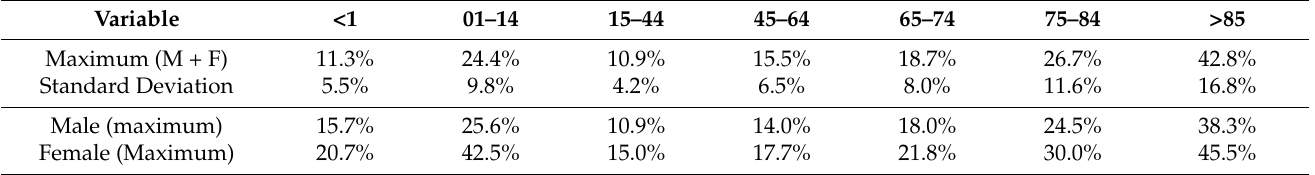
Table 2. Maximum value of EWM in England and Wales (2010–2020) by age band using weekly data, plus the standard deviation associated with the rolling EWM calculation.